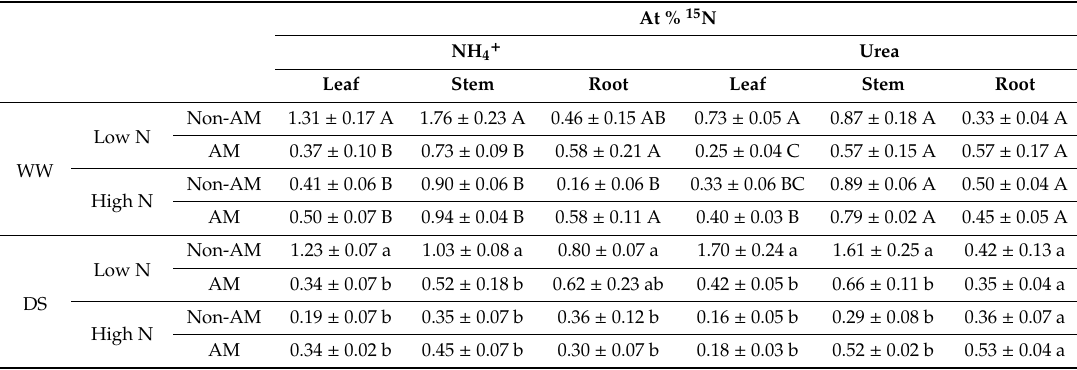
Table 2. Atoms % 15 N incorporated in leaf, stem and root of maize plants inoculated or not with the AM fungus Rhizophagus irregularis (AM), submitted to two water regimes (well-watered, WW or drought stress, DS for 14 days) and fertilized with low (3 µ M) or high (10 mM) ammonium or urea concentrations during the growing period. Plants were labelled with ammonium sulphate (60 atom % 15 N) or urea (98 atom % 15 N) for 3h before harvest.